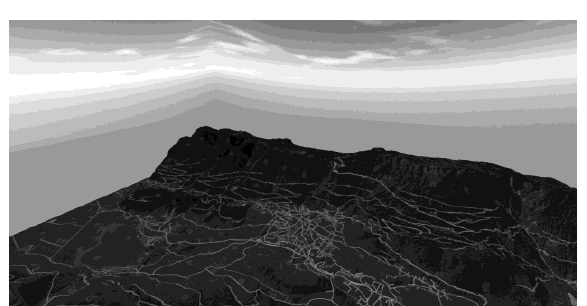
Figure 5. Terrain visualization with road